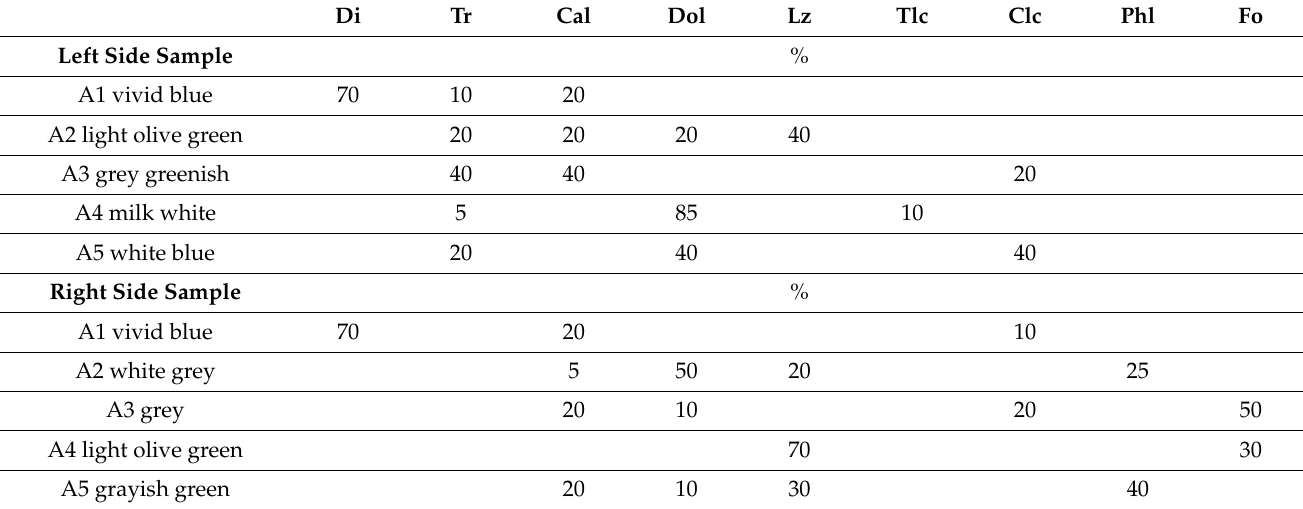
Table 3. Mineralogical composition of the samples from the areas 1–5 (Figure 9a,b). The semiquantitative analyses on XRPD data were performed with the program “PANalytical XPerth High Score”. Mineral name abbreviations: Di = diopside, Cal = calcite, Phl = phlogopite, Dol = dolomite, Tr = tremolite, Lz = lizardite, Fo = forsterite. [21].